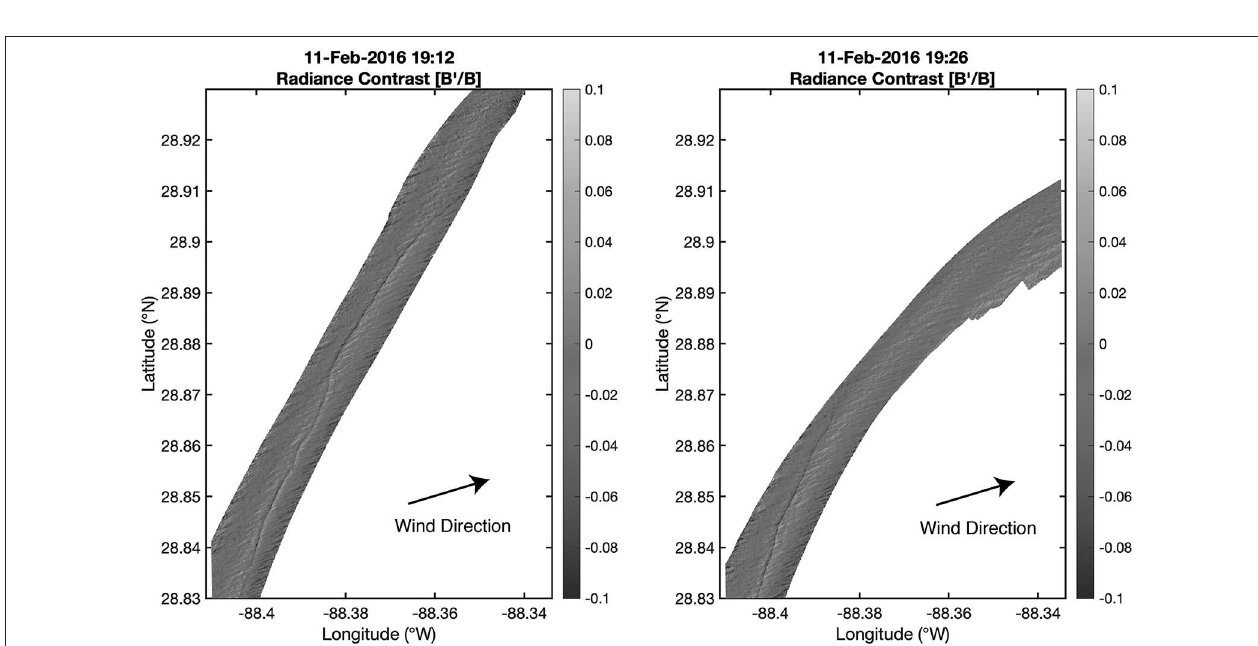
FIGURE 6 | Variations in sunglint intensity detected for two different aircraft passes of the same front with different view angles. The current gradients at the front appear differently from the two angles. This difference can be used to compute the magnitude of the front current gradient (adapted from Rascle et al., 2017; data available at Rascle et al.,